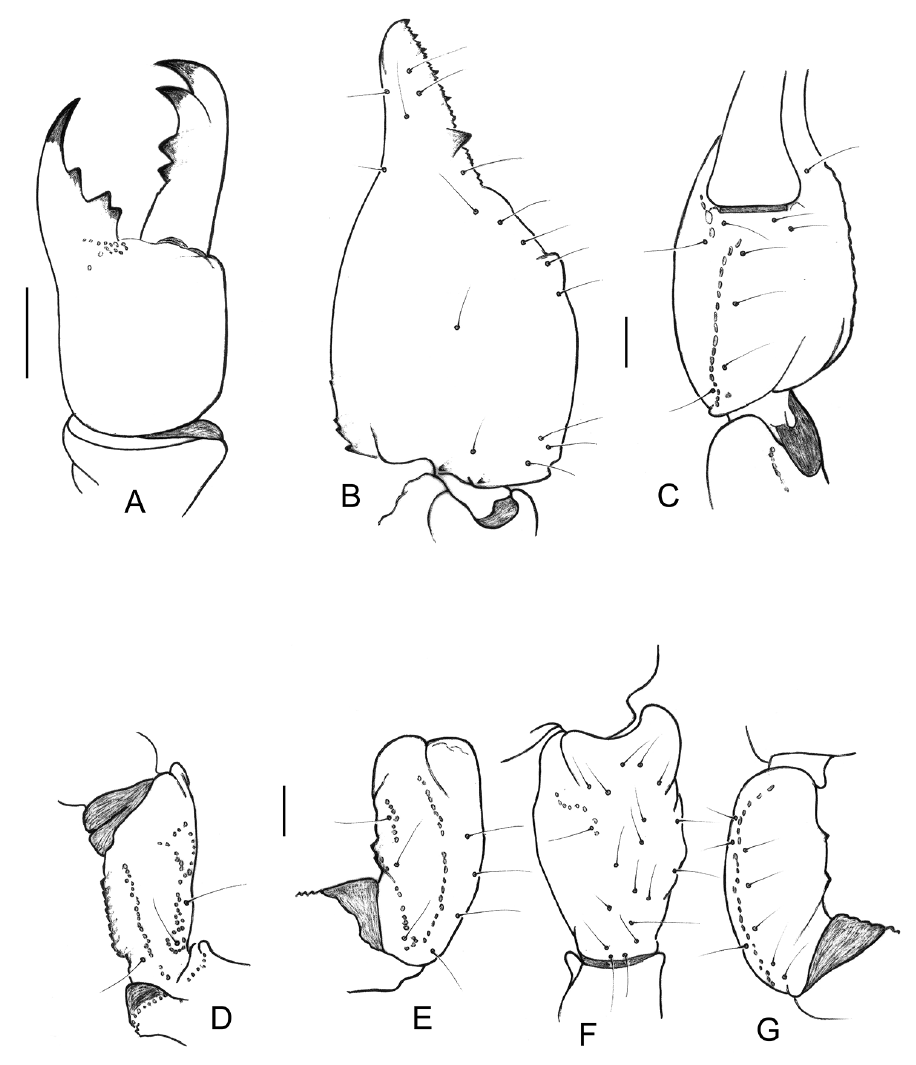
Figure 6. Teuthraustes giupponii sp. n. Female holotype. A Chelicera, dorsal aspect B–G Trichobothrial pattern B–C Chela, dorso-external and ventral aspects D Femur, dorsal aspect E–G Patella, dorsal E external F and ventral G aspects. Scale bars 1